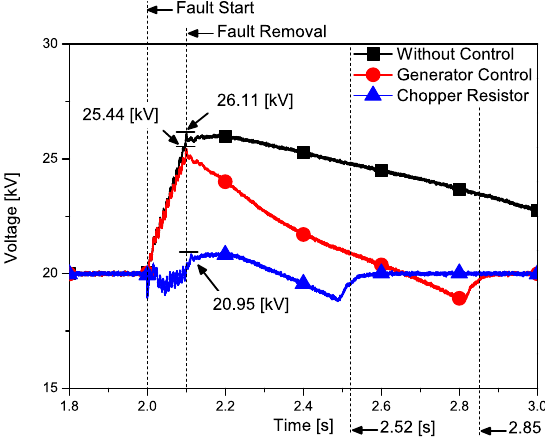
Figure 11. The DC voltage of the MVDC when the grid fault